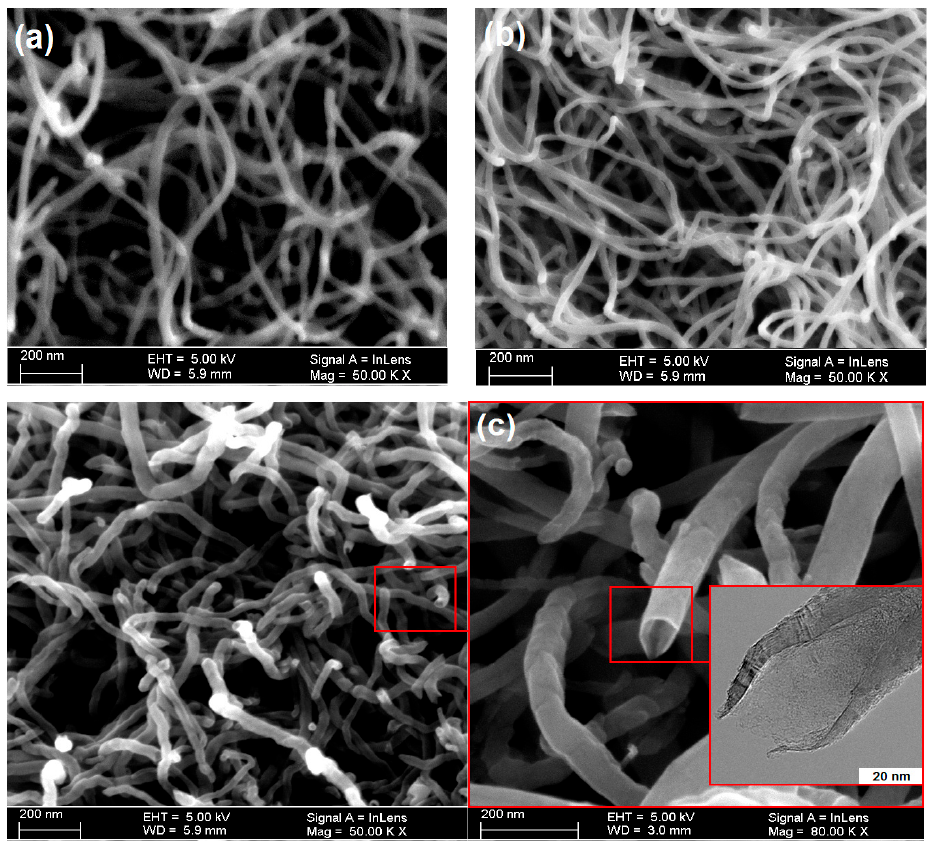
Figure 6. SEM micrographs of ( a ) pristine MWCNTs, ( b ) acid treated MWCNTs, and ( c ) amine functionalized MWCNTs.